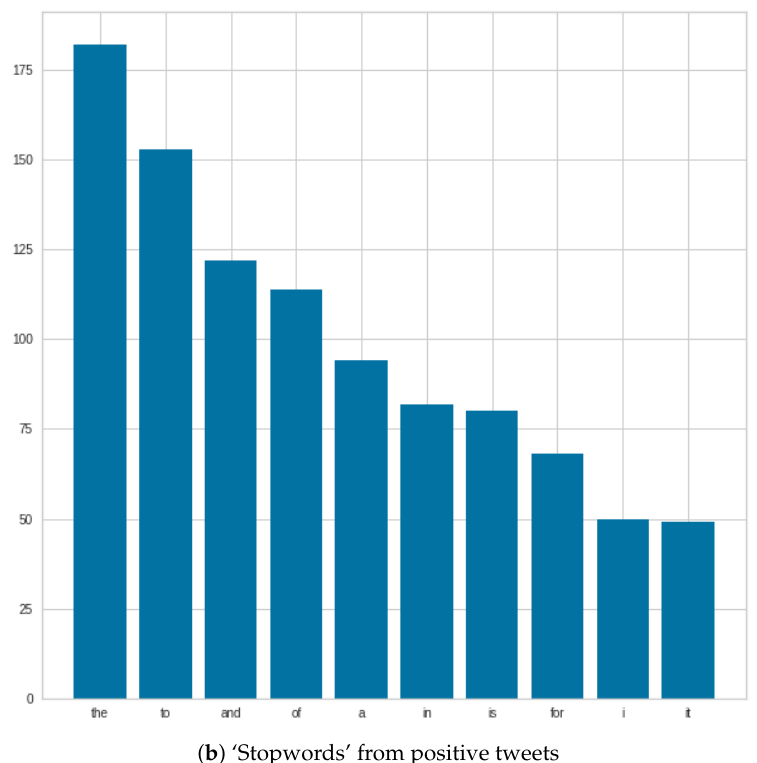
Figure 6. Negative and positive ‘Stopwords’. The time periods stands between 29 August 2021 and 31 August 2021.